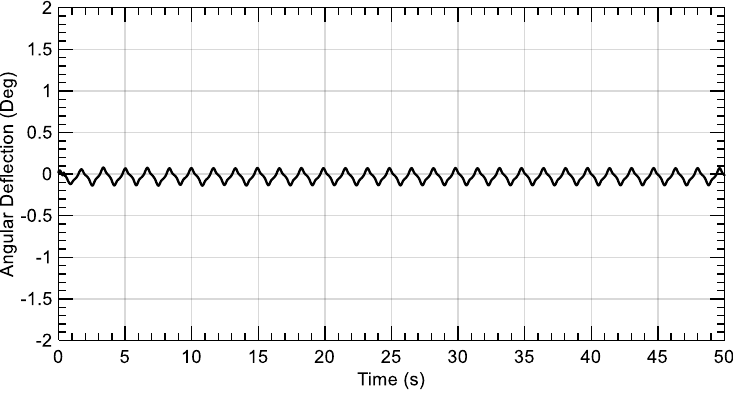
Figure 24. Tower top yawing deflection - Load case 2.